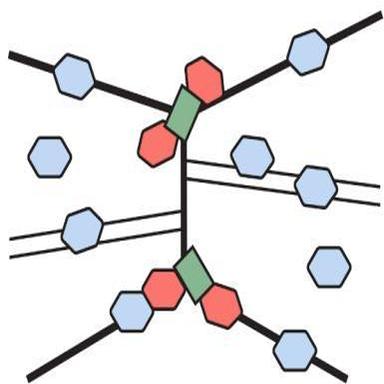
A schematic outlining the criteria that are used to classify the recrystallised grains into groups depending on their location.